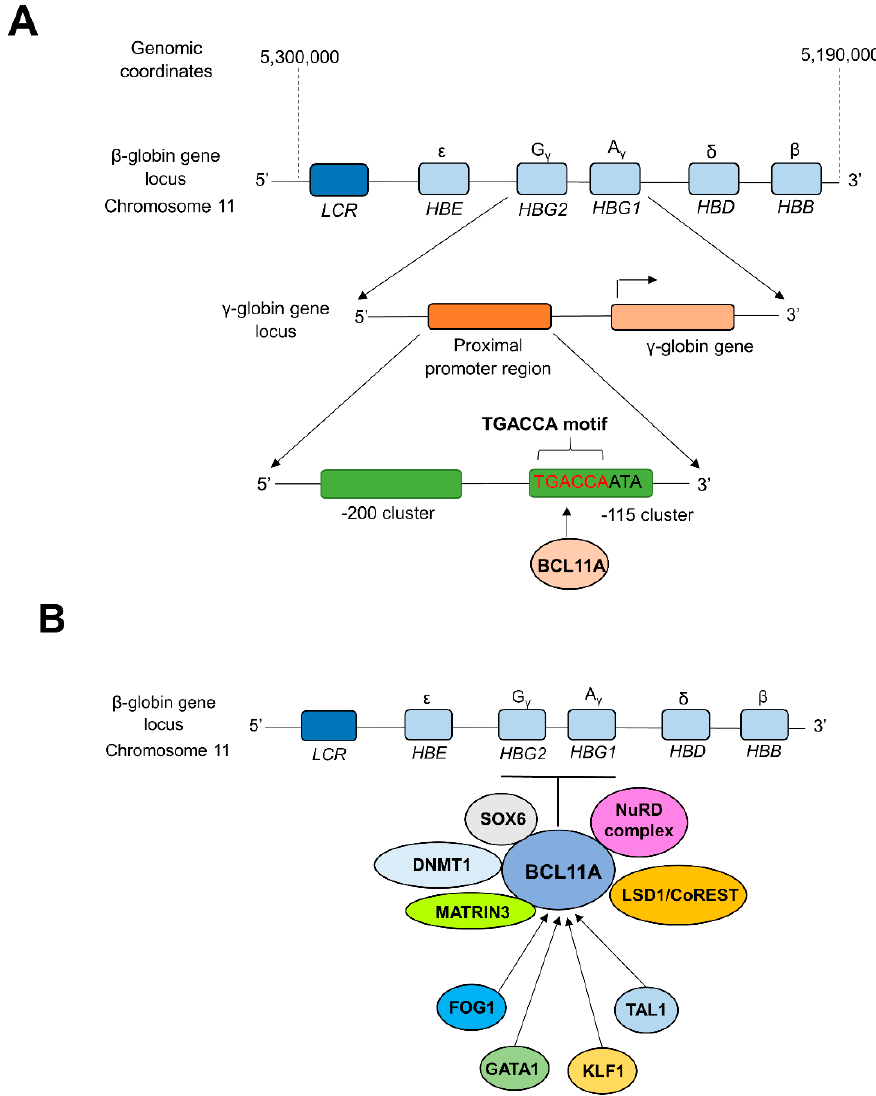
Figure 1. BCL11A-mediated transcriptional silencing of γ -globin. ( A ) Direct repression of the promoter region of γ -globin genes by BCL11A. Interactions between zinc finger motifs of BCL11A and the proximal TGACCA motif ( − 118 to − 113) of γ -globin promoter silence the expression of γ -globin during fetal to adult hemoglobin switching [86,89]. ( B ) Long-range interactions of BCL11A with multi-protein complexes and transcription factors. The level of expression of BCL11A is controlled by several transcription factors such as FOG1, GATA1, TAL1, etc. At the same time, BCL11A is capable of repressing the γ -globin expression through long-range interactions and cooperation with multi-protein complexes such as NuRD, DNMT1, MATRIN3, etc. [90–92]. LCR ; β -globin locus control region, HBE ; Hemoglobin Subunit Epsilon gene, HBG1 ; Hemoglobin subunit Gamma 1 gene, HBG2 ; Hemoglobin Subunit Gamma 2 gene, HBD ; Hemoglobin Subunit Delta gene, HBA ; Hemoglobin Subunit Alpha gene. NuRD; Nucleosome Remodeling and Deacetylase, LSD1/CoREST; Lysine Specific Demethylase 1/Repressor Element 1 Silencing Transcription Factor Corepressor 1, MATRIN3; Nuclear Matrix Protein-3, DNMT1; DNA Methyltransferase 1, SOX6; SRY-box transcription factor 6, TAL1; T-cell Acute Lymphoblastic Leukemia 1, KLF1; Kruppel-Like Factor 1, GATA1; GATA binding protein 1, FOG1; Zinc finger protein FOG family member 1.